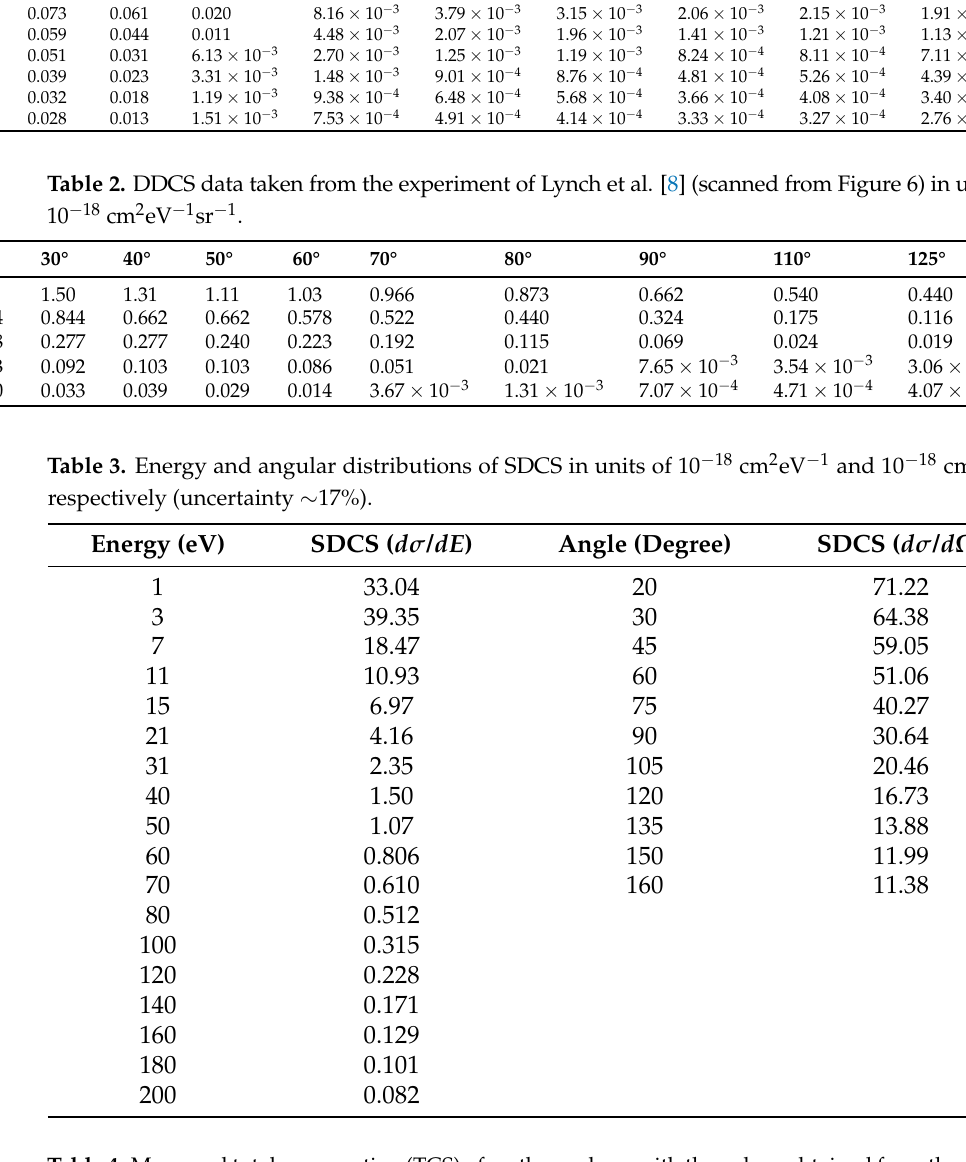
Table 4. Measured total cross section (TCS) of methane along with the values obtained from